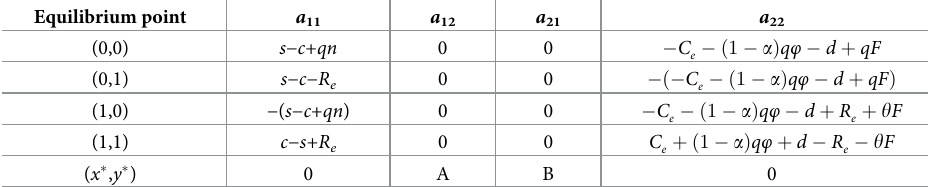
Table 3. Local equilibrium point value table. Equilibrium